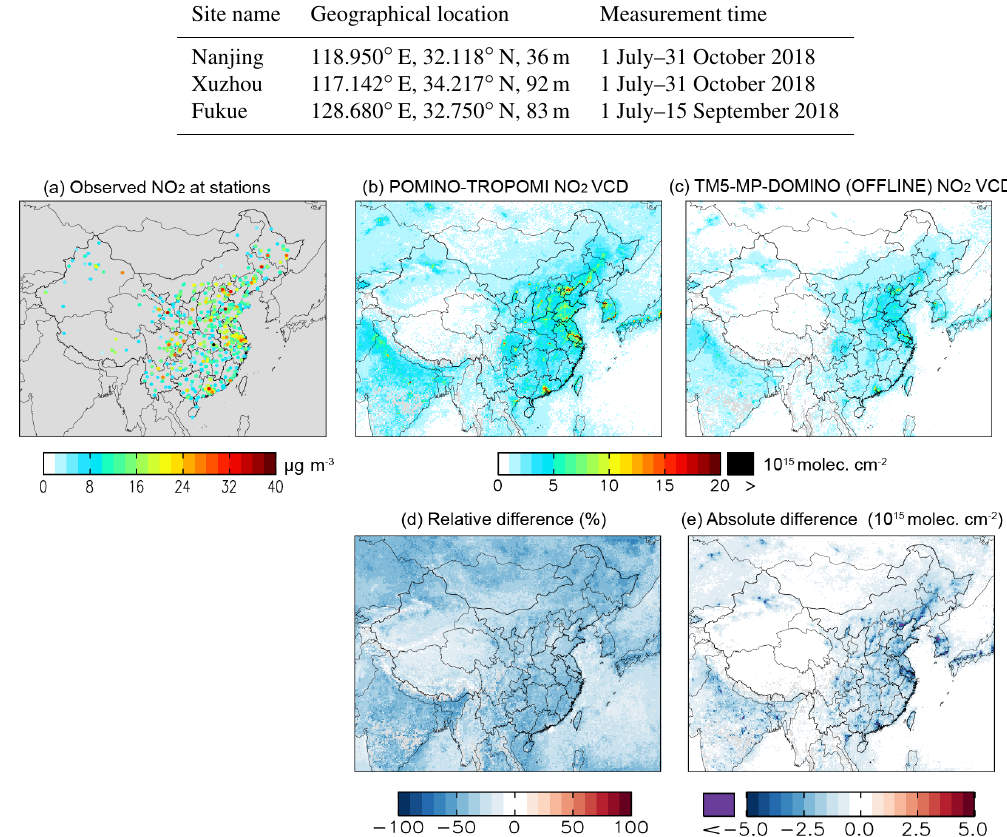
Figure 4. The spatial distribution of (a) near-surface NO 2 concentrations at monitoring stations, (b) POMINO-TROPOMI NO 2 VCD, and (c) TM5-MP-DOMINO (OFFLINE) NO 2 VCD at 0 . 05 ◦ × 0 . 05 ◦ grid in July 2018. Panels (d) and (e) are relative and absolute difference of TM5-MP-DOMINO (OFFLINE) to POMINO-TROPOMI NO 2